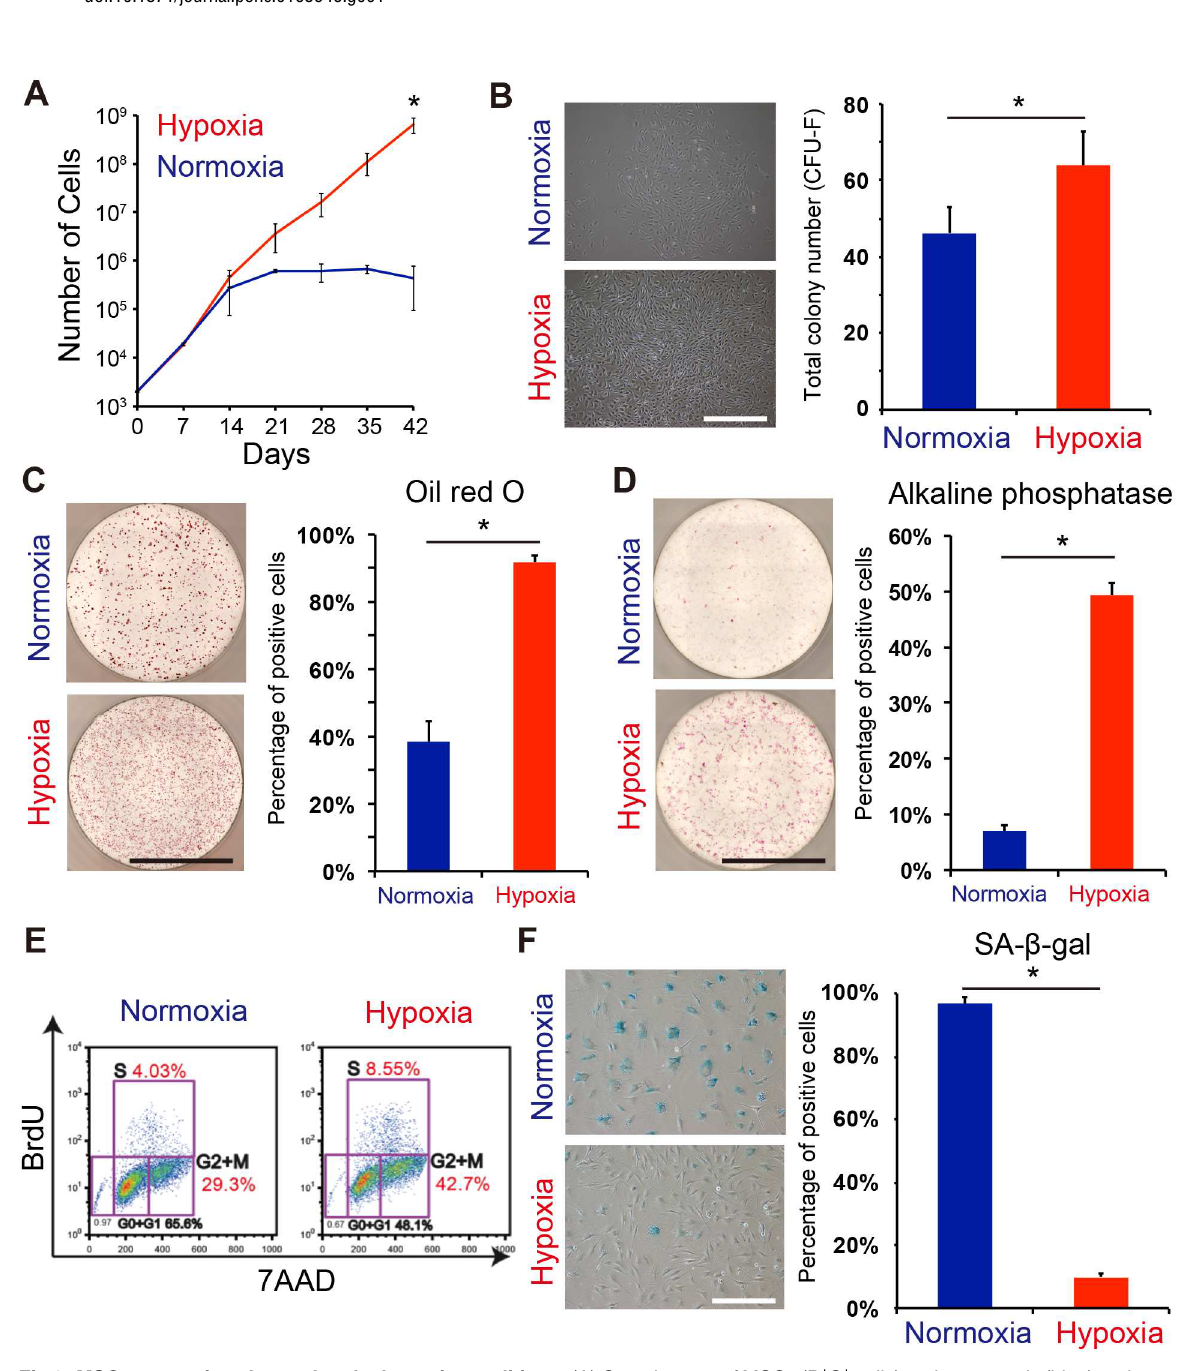
Fig 2. MSC potency is enhanced under hypoxic conditions. (A) Growth curve of MSCs (P + S + cells) under normoxic(blue) and hypoxic (red) conditions. (B) Numbers of CFU-Fs detected at 14 days after plating 1000cells (n = 3). Phase-contrast micrographsof MSC coloniesare shown. The small box representsa high-resolution image (scale bar = 50 μ m). (C, D) Capacity of MSCs to differentiateinto adipocytesand osteoblasts(scale bar = 3.5 mm). Quantitative analysisof the MSC differentiation capacity at passage 4 (n = 3). (E) Flow cytometric analysisof BrdU/7AAD-stained P + S + cells under normoxic (left) and hypoxic (right) conditionsat passage 4. (F) SA- β -galassay of cultured MSCs. Senescent cells were countedfor quantitative analysis(n = 3, scale bar = 50 μ